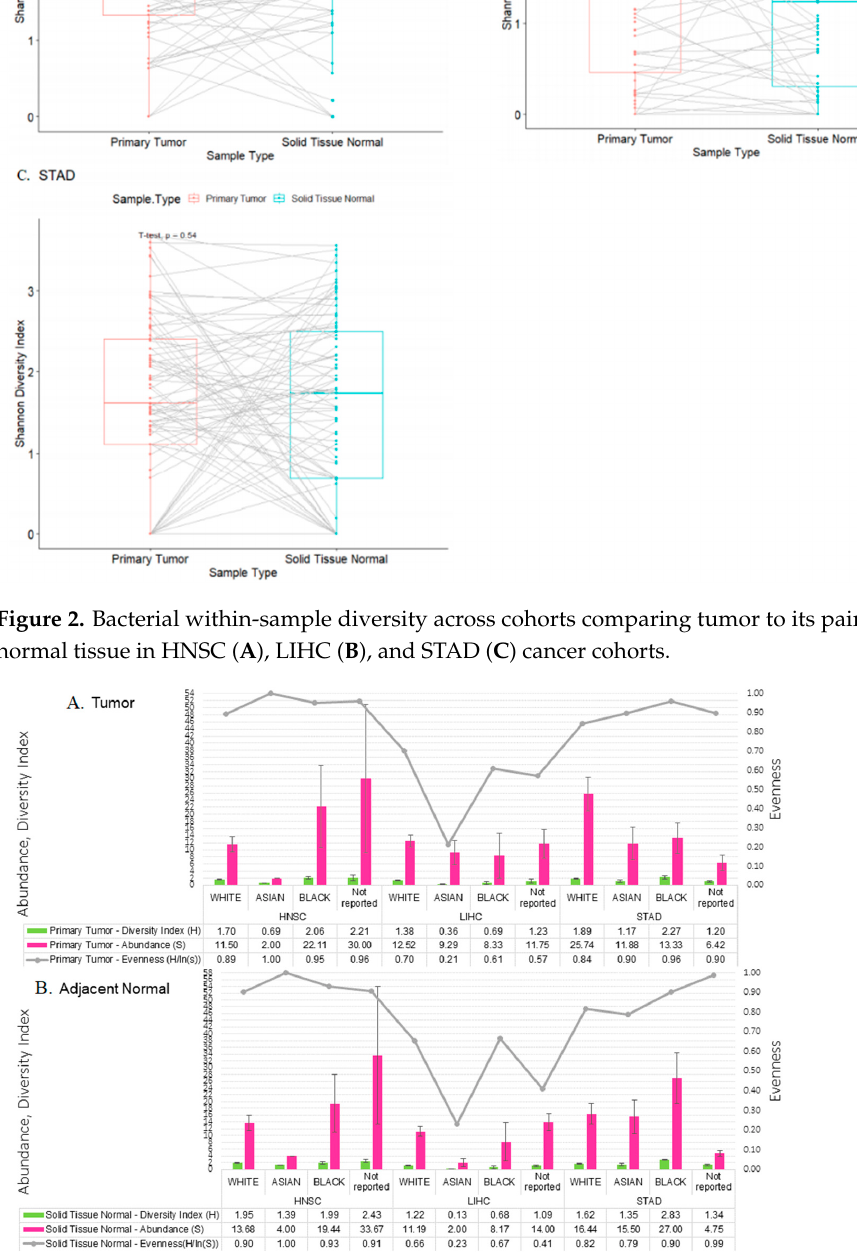
Figure 3. Microbial diversity profiles for infection associated cancers (HNSC, LICH, STAD) among different racial groups with standard error bars for tumor ( A ) and adjacent normal ( B ). Average absolute abundance (pink bars), within-sample diversity index as determined by Shannon-Wiener index (green bars), and evenness (y-axis) of species abundance per racial group in each cohort is shown as line graph. Evenness measure is being used as complement to Shannon-Wiener diversity index, where ‘1’ indicates complete evenness, and ‘0’ indicates high diversity.